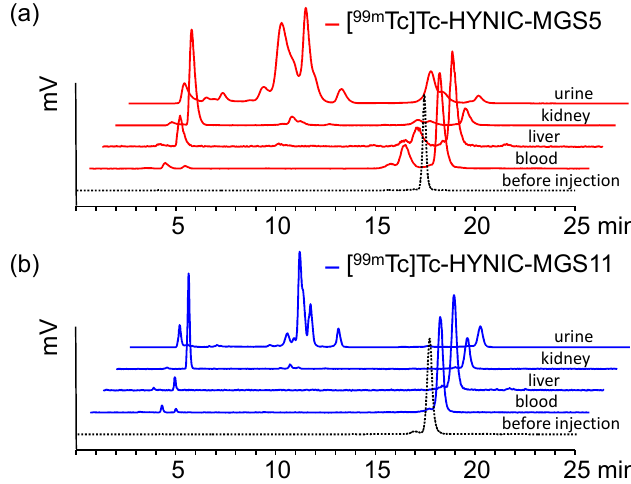
Figure 6. Radiochromatograms for blood, liver, kidney and urine from metabolite studies in BALB/c mice injected with ( a ) [ 99m Tc]Tc-HYNIC-MGS5 (red) and ( b ) [ 99m Tc]Tc-HYNIC-MGS11 (blue) as analyzed 10 min p.i.; dashed line showing the radiochromatogram of the radiopeptide before injection. Ocak et al. have suggested a common enzymatic cleavage site of different MG analogs between Asp and Phe-NH2 when incubated in human serum [26]. Recently, Sauter et al. studied the stability of three 177 Lu-labeled MG analogs in different human proteases finding that substitution of Met